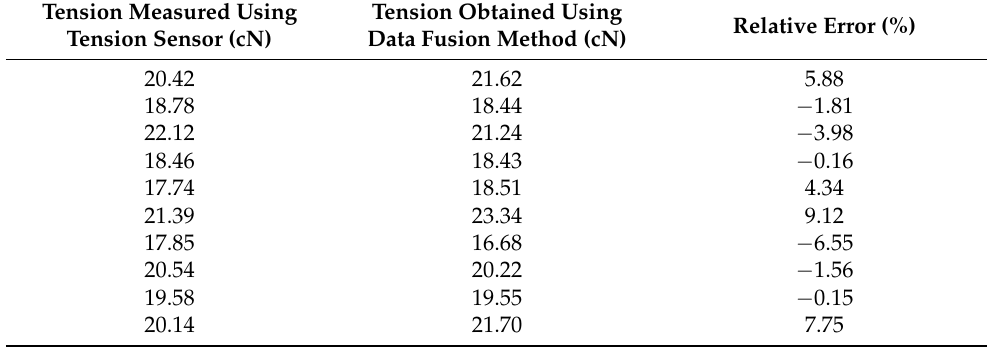
Figure 17. Experimental comparisons of adaptive-weighted tension fusion. Table 3. Relative error of data fusion yarn tension detection.